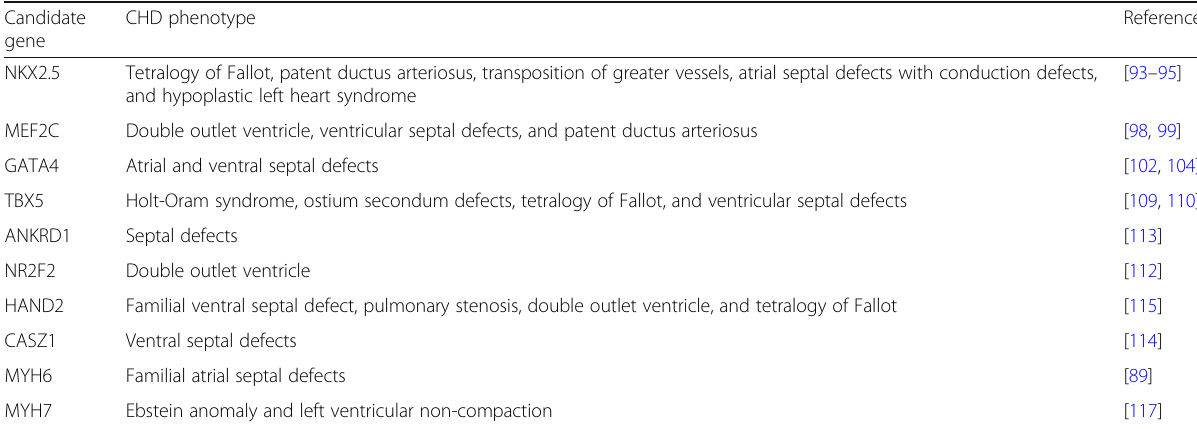
Table 1 Summary of genes involved in cardiac morphogenesis. Mutations of these important genes lead to various phenotypes of